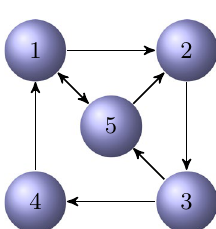
Fig. 7 A strongly connected directed graph